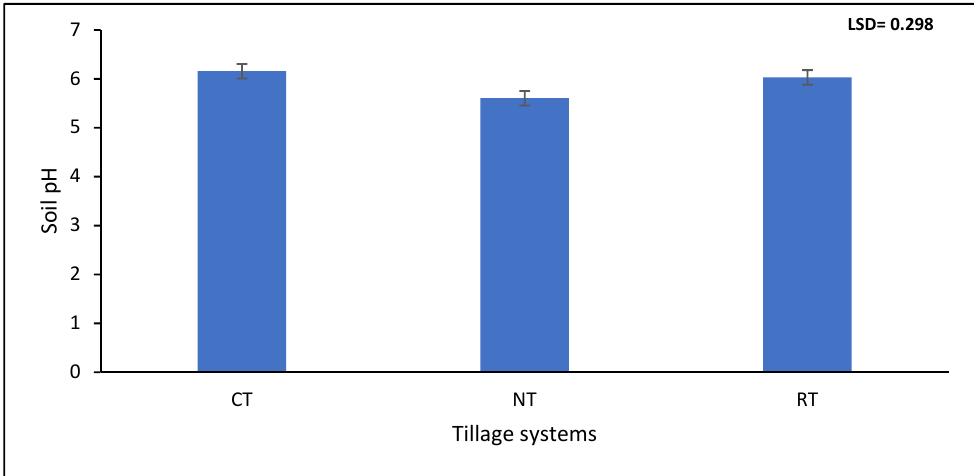
Figure 2. Soil pH at three different tillage treatments of no-till (NT), rotational tillage (RT), and conventional tillage (CT) after 17 years of trial establishment.